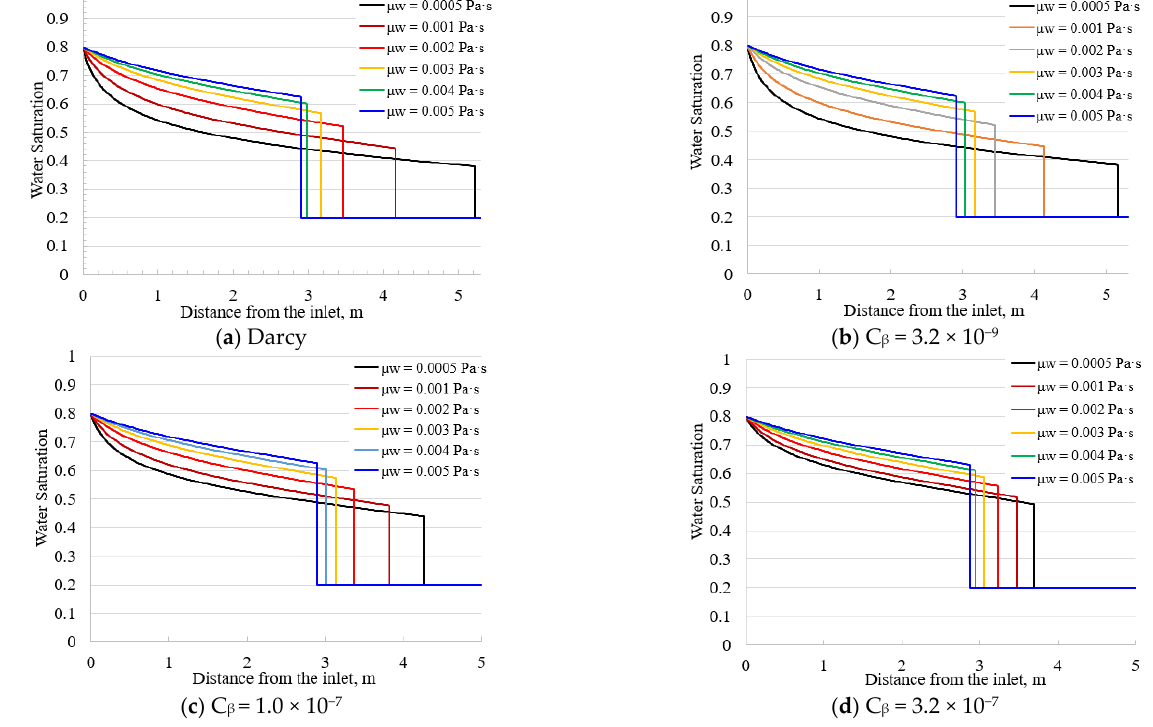
Figure 6. Water saturation profiles of Darcy versus Forchheimer flow with different fluid viscosities.